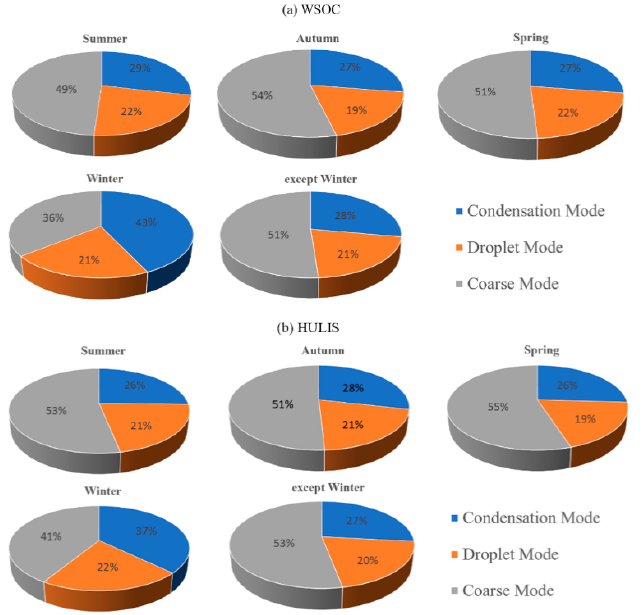
Figure 5. Proportion of condensation mode, droplet mode and coarse mode in WSOC ( a ) and HULIS-C ( b ).